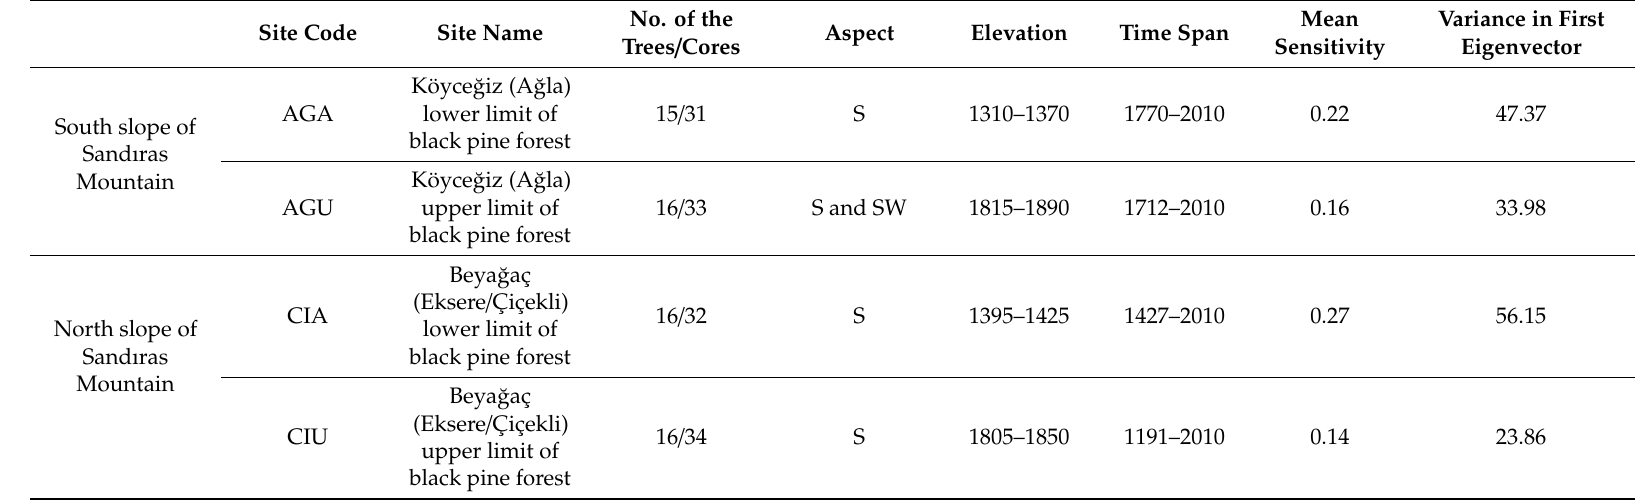
Table 1. Site information and summary statistics for site chronologies; from the ARSTAN program [44]. The lower elevation site chronologies (highlighted in bold) were more sensitive to climate variability than the higher elevation site